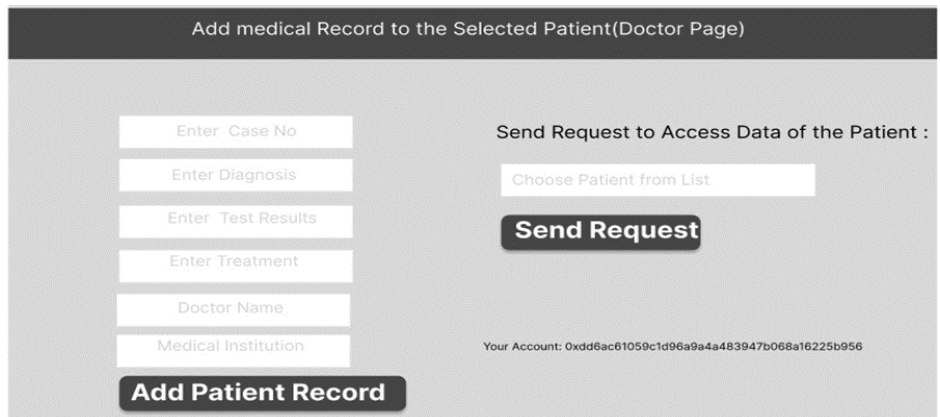
Figure 12. Update patient